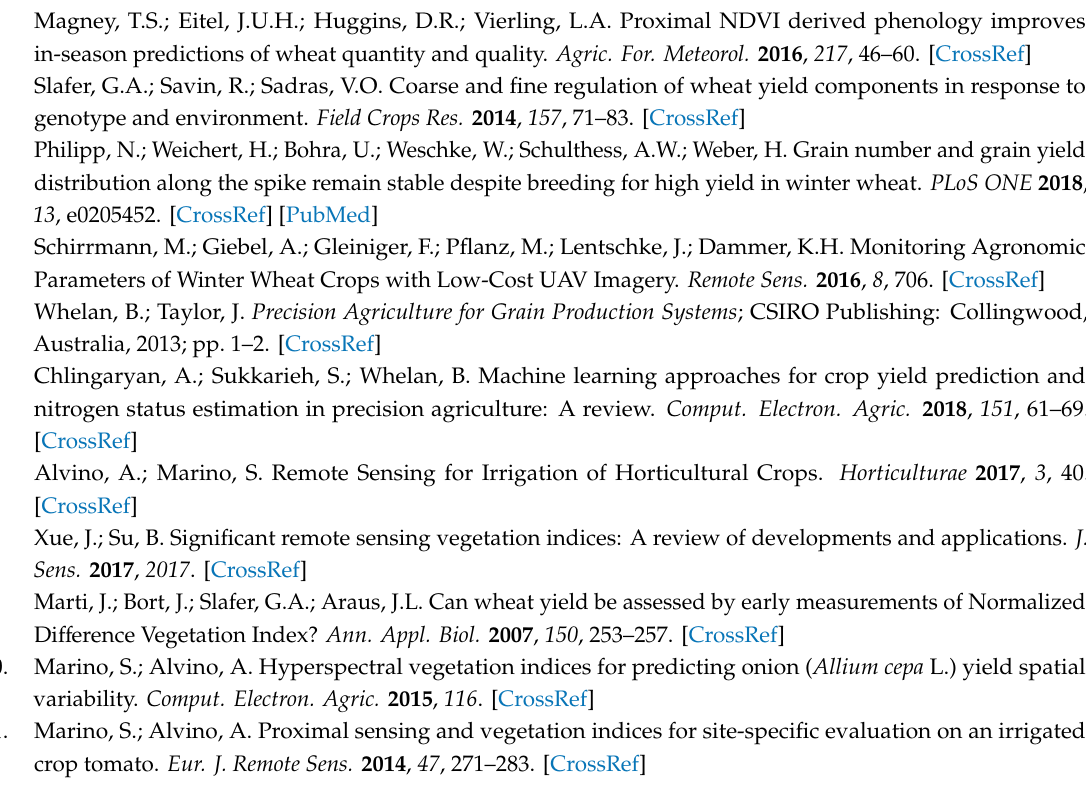
( g ) VIs vs. spike number (10 cultivars) ( h ) VIs vs. spike number (8 cultivars, Akim, Rebelde) Figure A2. VIs vs. yield ( a ), biomass ( c ), spike weight ( e ), spike number ( g )regression (R 2 and polynomial functions) of 10 cultivars (yellow) (Left) and VIs vs. yield ( b ), biomass ( d ), spike weight ( f ), spike number ( h ) regression (R 2 and polynomial functions) of 8 cultivars (yellow); cultivar Akim (red) and cultivar Rebelde (blue).